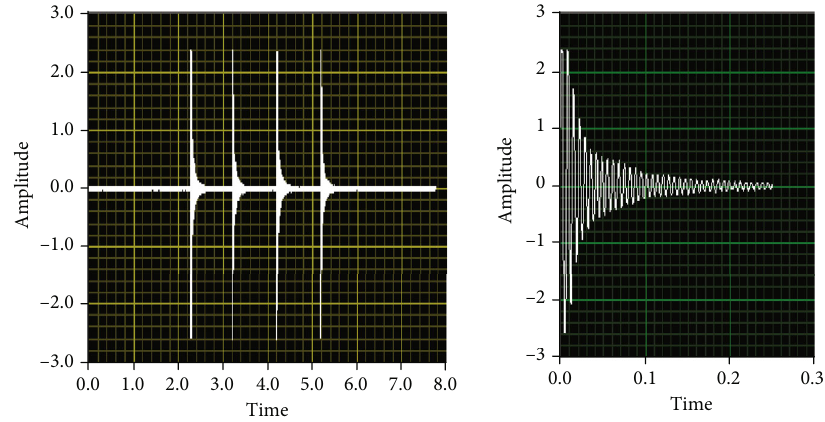
Figure 2: Acceleration response signals as time magnitude.